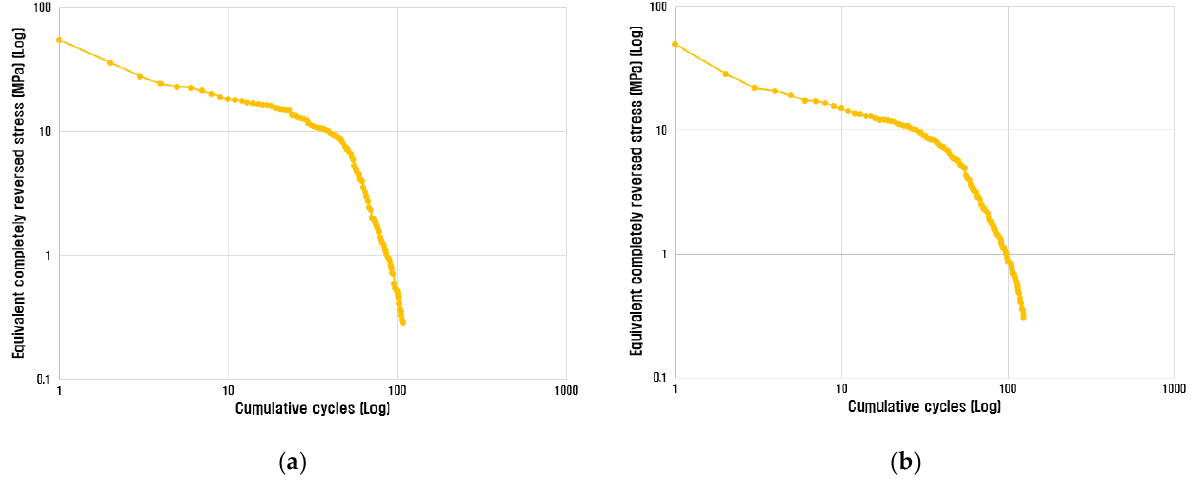
Figure 16. Load spectrum at each fastening device when loading part is not lifted: ( a ) fastening device 1; ( b ) fastening device 2.